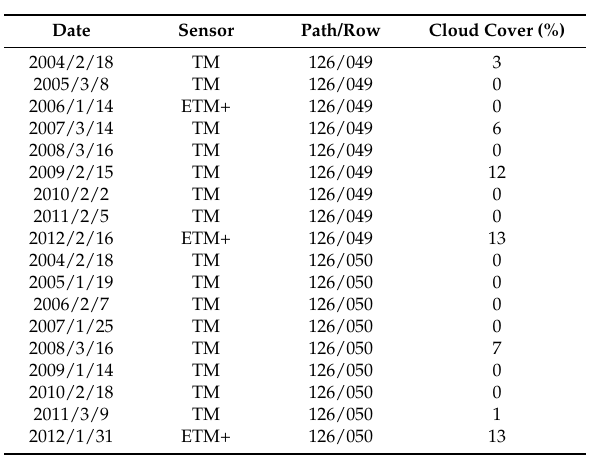
Table 1. Characteristics of the Landsat data used in the study. TM (Landsat 5 Thematic Mapper). ETM+ (Landsat 7 Enhanced Thematic Mapper plus). Path/row numbers define the location of the two Landsat footprints